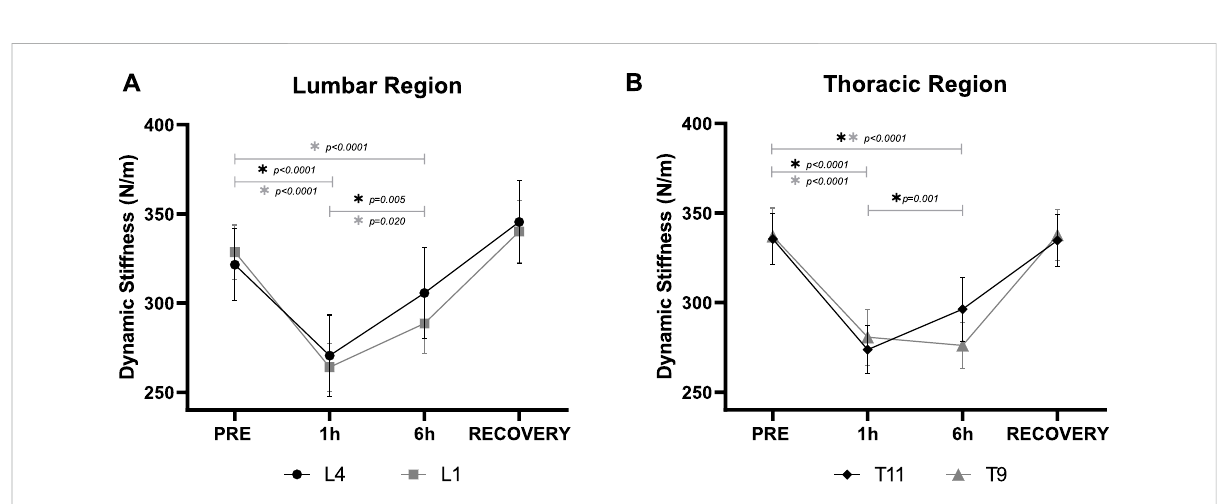
FIGURE 5 Mean(±SEM)bilateralm. erectorspinae myofascialdynamicstiffness(N/m)inthe (A) :LowerLumbar(L4)andUpperLumbar(L1),and (B) :Lower Thoracic (T11), and Middle Thoracic (T9) regions before (PRE), during Dry Immersion (DI) after 1 (1 h) and 6 (6 h) hours, and 30 min after being raised out of DI (RECOVERY). *Statistically signi fi cant difference ( p < 0.05) between time points (post-hoc Bonferroni corrected t